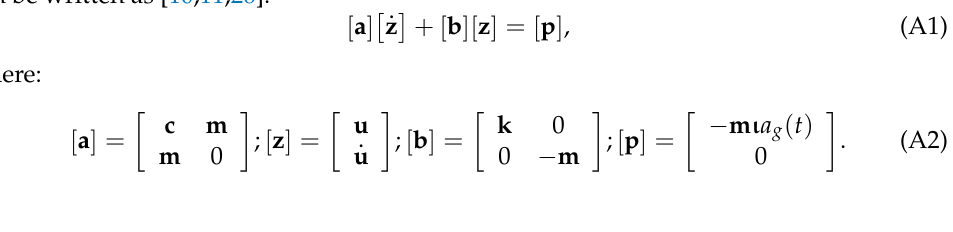
Figure S8: Bar plot for story shear vs. for RSA-SRSS error (error 2) and RSA-CQC error (error 3), average of stories, first story and roof, Figure S9: Bar plot for damper shear V D for RSA-SRSS error (error 2) and RSA-CQC error (error 3), average of stories, first story and roof, Figure S10: RSA-SRSS error (type 2) max and min envelope for all cases versus index I PS 5 , Figure S11: RSA- SRSS error (type 2) max and min envelope for all cases versus index I TLL 1 . Figure S12: RSA-SRSS error (type 2) max and min envelope for all cases versus index I A 1 , Figure S13: RSA-CQC error (type 3) max and min envelope for all cases versus index I PS 5 , Figure S14: RSA-CQC error (type 3) max and min envelope for all cases versus index I TLL 1 , Figure S15: RSA-CQC error (type 3) max and min envelope for all cases versus index I A 1 . Table S1: Maximum value of I PS 5 to limit the max and min RSA-SRSS error (error 2), Table S2: Maximum value of I TLL1 to limit the max and min RSA-SRSS error (error 2), Table S3: Maximum value of I A1 to limit the max and min RSA-SRSS error (error 2), Table S4: Maximum value of I PS 5 to limit the max and min RSA-CQC error (error 3), Table S5: Maximum value of I TLL1 to limit the max and min RSA-CQC error (error 3), Table S6: Maximum value of I A1 to limit the max and min RSA-CQC error (error